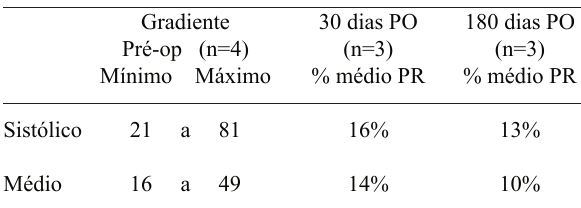
Tabela 1. Porcentual de redução (PR) dos gradientes de pressão determinados pelo ecocardiograma no pré e